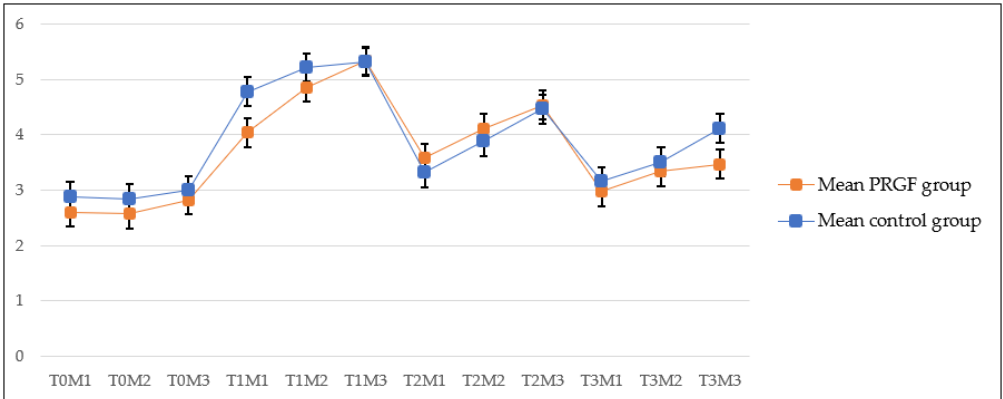
Figure 2. Means and standard derivations of patellar ligament thickening at the different follow-ups.